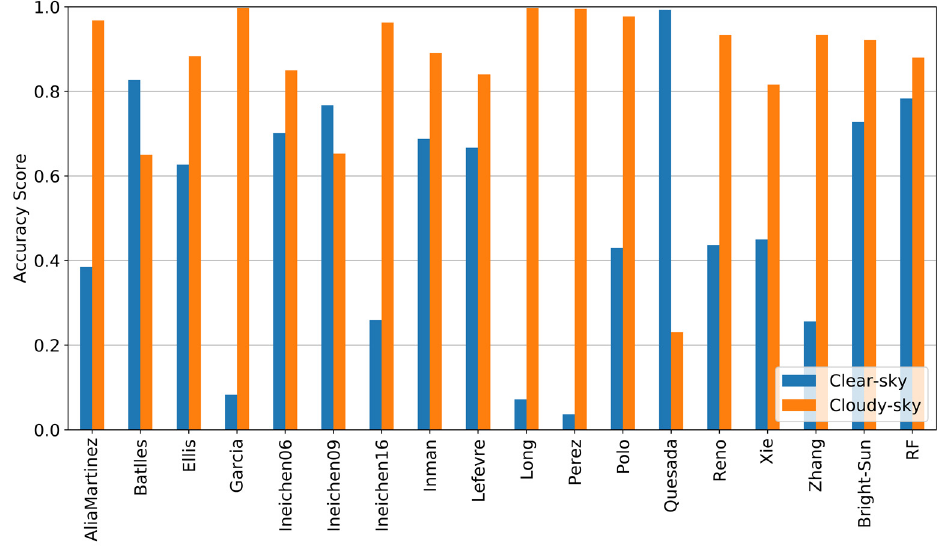
Figure 5. The accuracy score of CSD sky methods and the RF CSD model under clear (blue bar) and cloudy (orange bar) conditions.